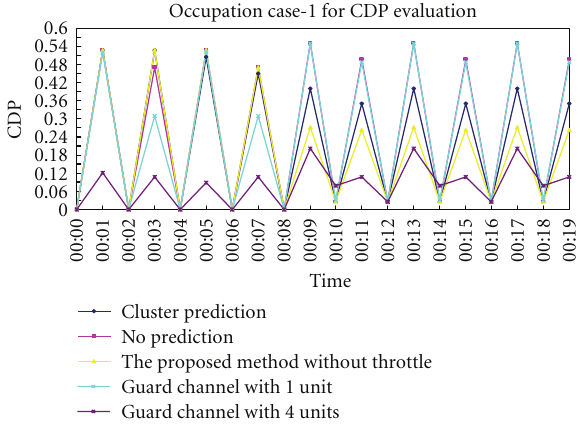
Figure 7: Comparison of CDPs among the proposed method and others for occupation case.